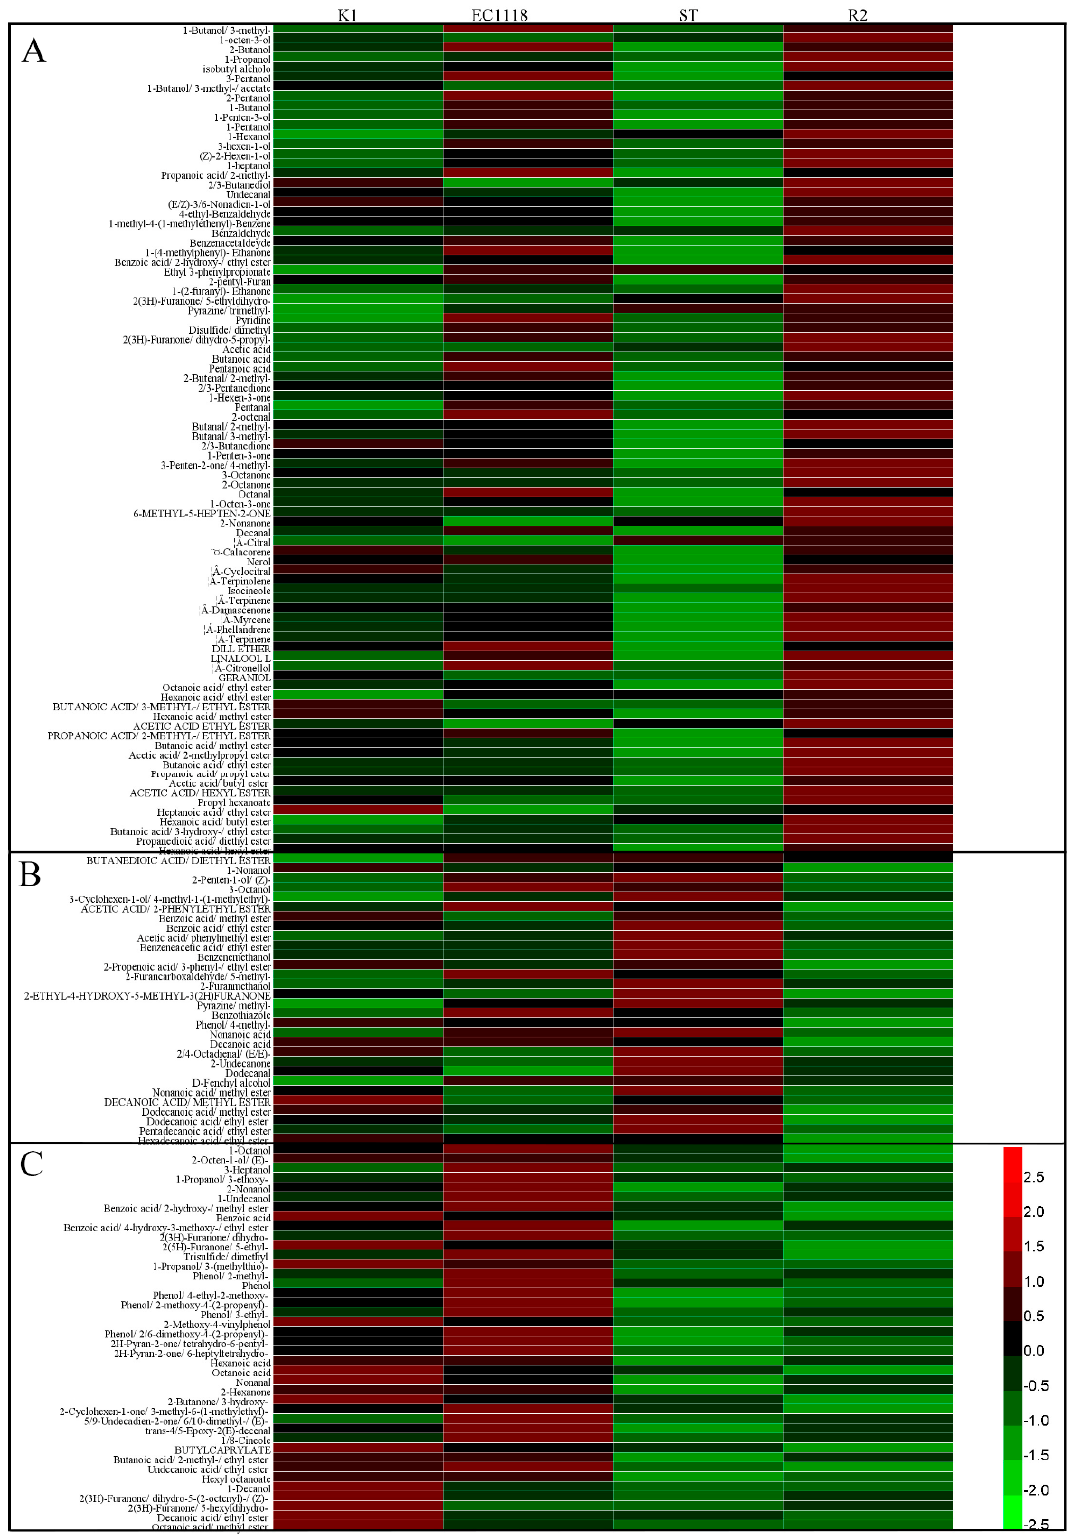
Figure 2. Heat map of 156 compounds with different aroma characteristics of four different yeast fermented icewines. In the figure, the rows represent the compounds, and the columns represent the yeasts used for fermentation. Distance measure used in clustering rows (compounds) was Euclidean method, and the data were standardized before cluster analysis. ( A ), the compounds were higher in R2 yeast fermented icewine; ( B ), the compounds were higher in ST yeast fermented icewine; ( C ), the compounds were higher in K1 and EC1118 yeast fermented